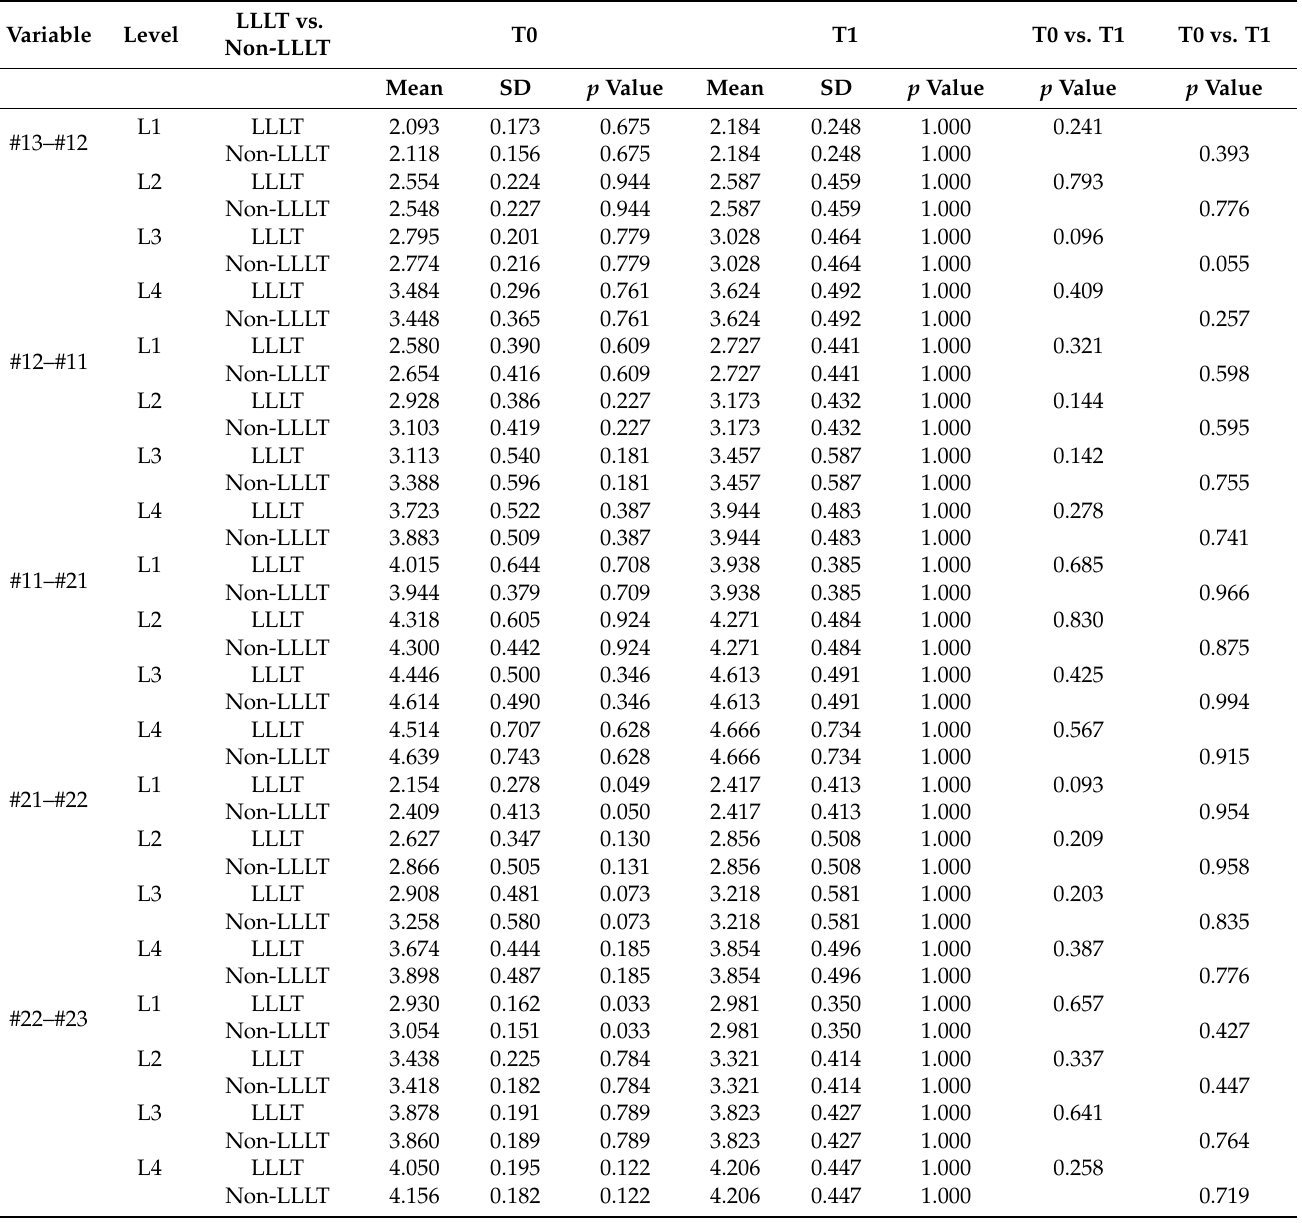
Table 2. IRW of the maxilla (both sides) at various levels. LLLT and non-LLLT differences among pre- and post-treatment groups—anterior quadrant teeth.